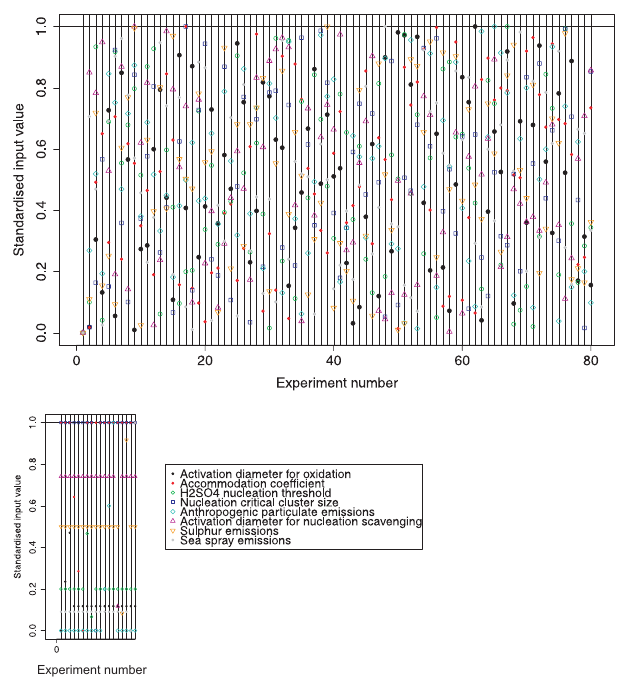
Fig. 4. Upper: the design used here. Lower: the design used in Spracklen